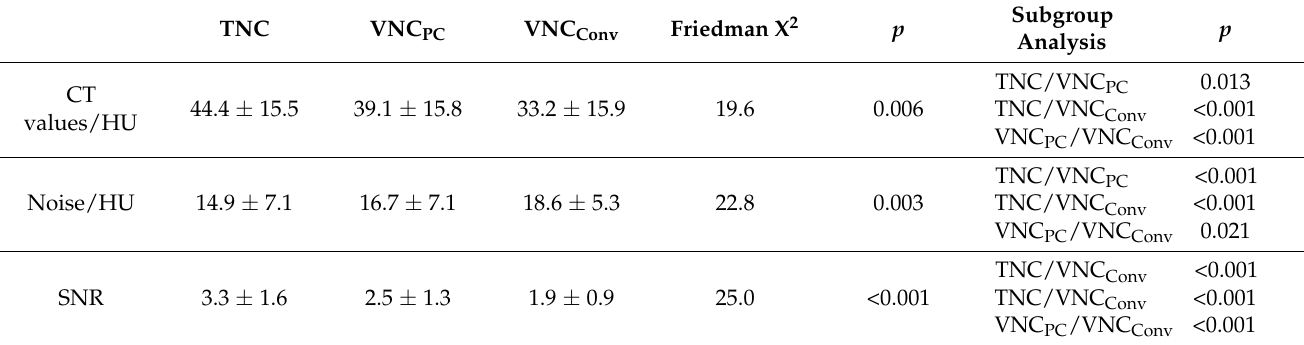
Table 2. Quantitative image quality parameters compared between TNC-, VNC PC -, and VNC Conv -series.